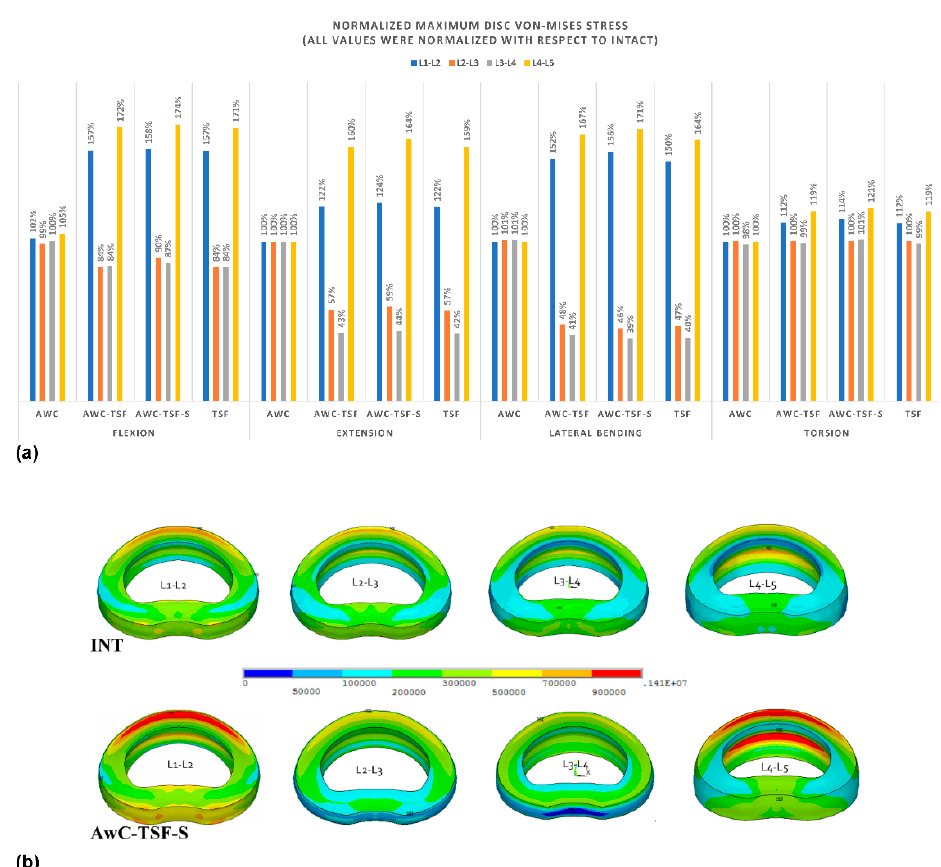
Figure 4. ( a ) Normalized maximum von Mises stress on the disc at each level in all implanted models. ( b ) von Mises stress distribution of the disc annulus under flexion for the INT and AwC- TSF-S